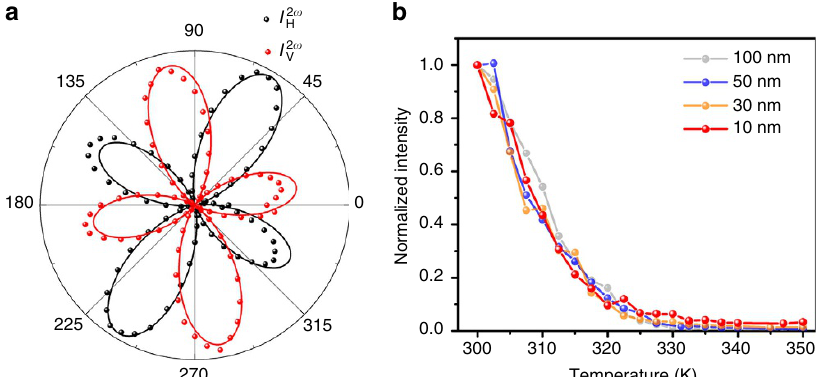
Figure 4 | Thicknesses-dependent second-harmonic generation (SHG). ( a ) Polar plots of the SHG intensity in H and Vdirections (laboratory coordinates) as a function of the excitation laser linear polarization for a 100nm thick CIPS flake. ( b ) Temperature dependence of the SHG intensity for CIPS flakes with thickness of 100, 50, 30 and 10nm, respectively. The SHG intensity of each thickness is normalized to its intensity at